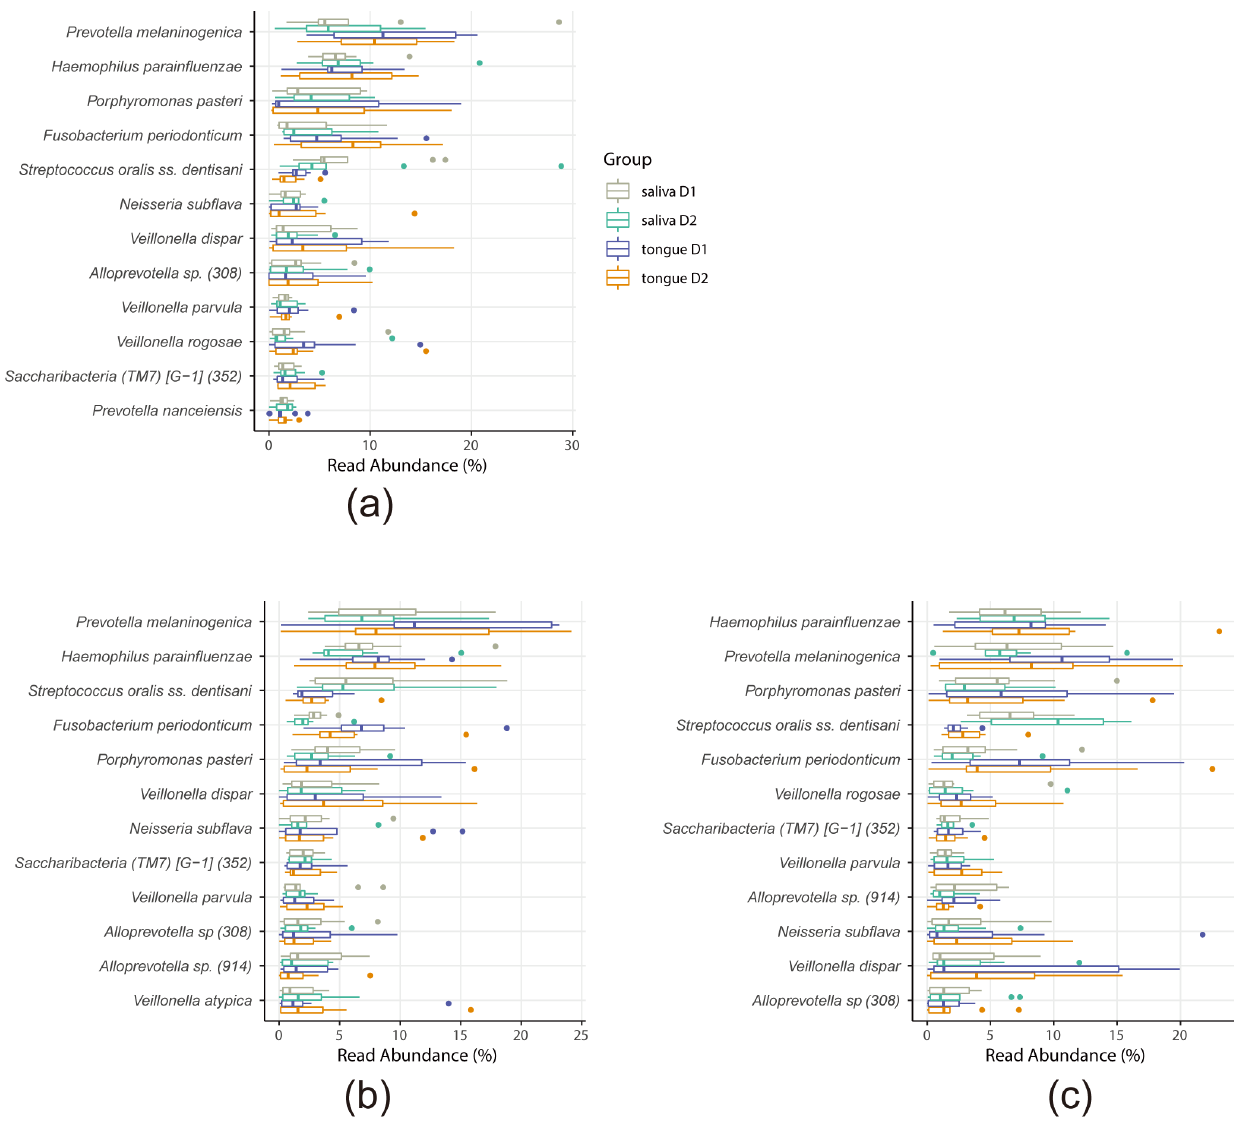
Figure 7. Box plots of OTU abundance. The abundances of top 12 operational taxonomic units (OTUs) based on the clustered OTU table for the no tablet ( a ), protease tablet ( b ), and plain tablet ( c ) treatments are shown. The data are colored depending on the group (saliva or tongue, and D1 or D2). No bacterial species showed differential abundance before (D1) or after (D2). Taxon IDs in eHOMD are indicated in the